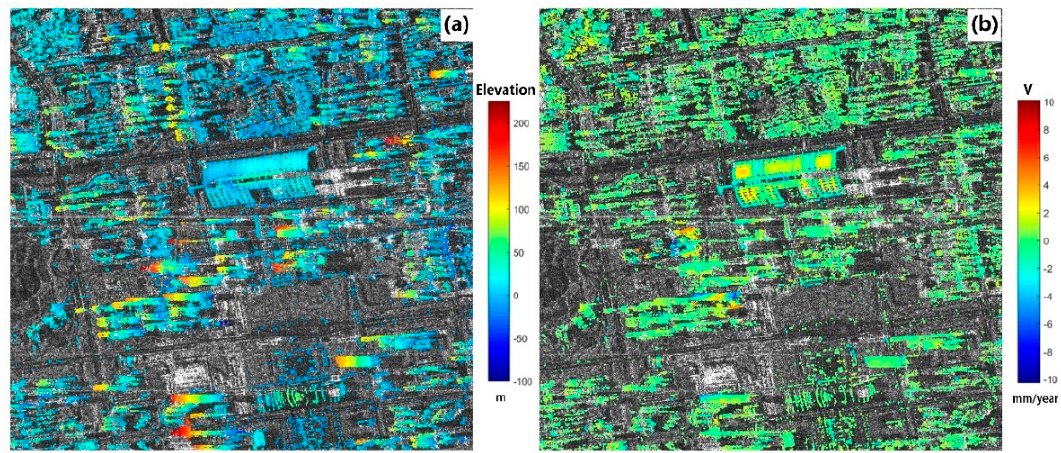
Figure 5. The absolute elevation map ( a ) and deformation rate map ( b ) of the study area; the elevation is calculated by combining the SRTM (NASA’s Shuttle Radar Topography Mission) DEM and the height error.